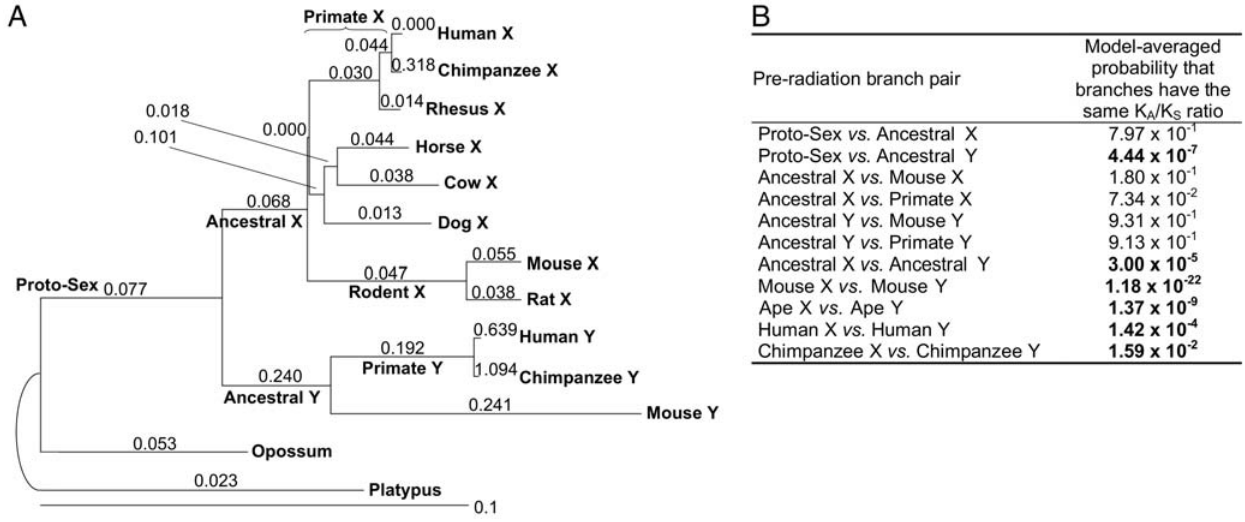
Figure 2. Pre-radiation phylogeny and evolutionary rate comparisons. (A) Phylogeny for the pre-radiation topology. Exons with less than 50% bootstrap support for clades with either the pre- or post-radiation topology, fewer than 24 nucleotides aligned across all species, or inconsistent with the topology of the whole gene were excluded. Branch lengths are proportional to the estimated synonymous substitutions per site, and are labeled with the nonsynonymous-to-synonymous rate ratios (K A /K S ). (B) Branch length comparisons for the pre-radiation topology. We present the model-averaged probabilities (not P values) that two branches have the same Ka/Ks ratio, and so corrections for multiple tests are neither needed nor appropriate (see Materials and Methods). Significant values are shown in